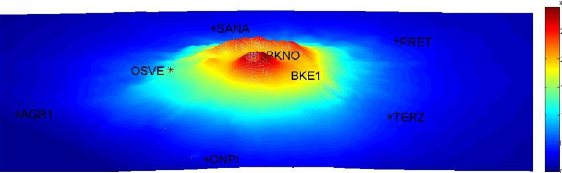
Figure 4. Gravitational load ( t * g * h) as function of the volcano to- pography.